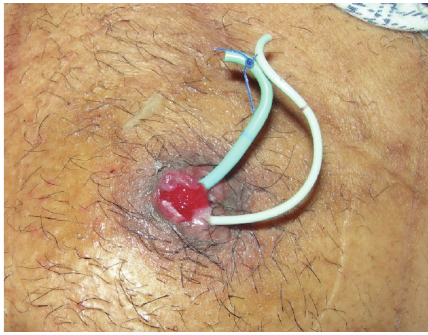
Figure 1: View of the ostomy before cryotherapy.